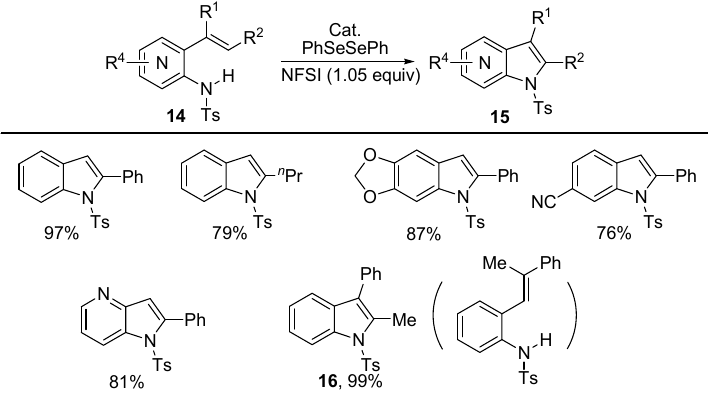
Scheme 7. Organoselenium-catalyzed synthesis of